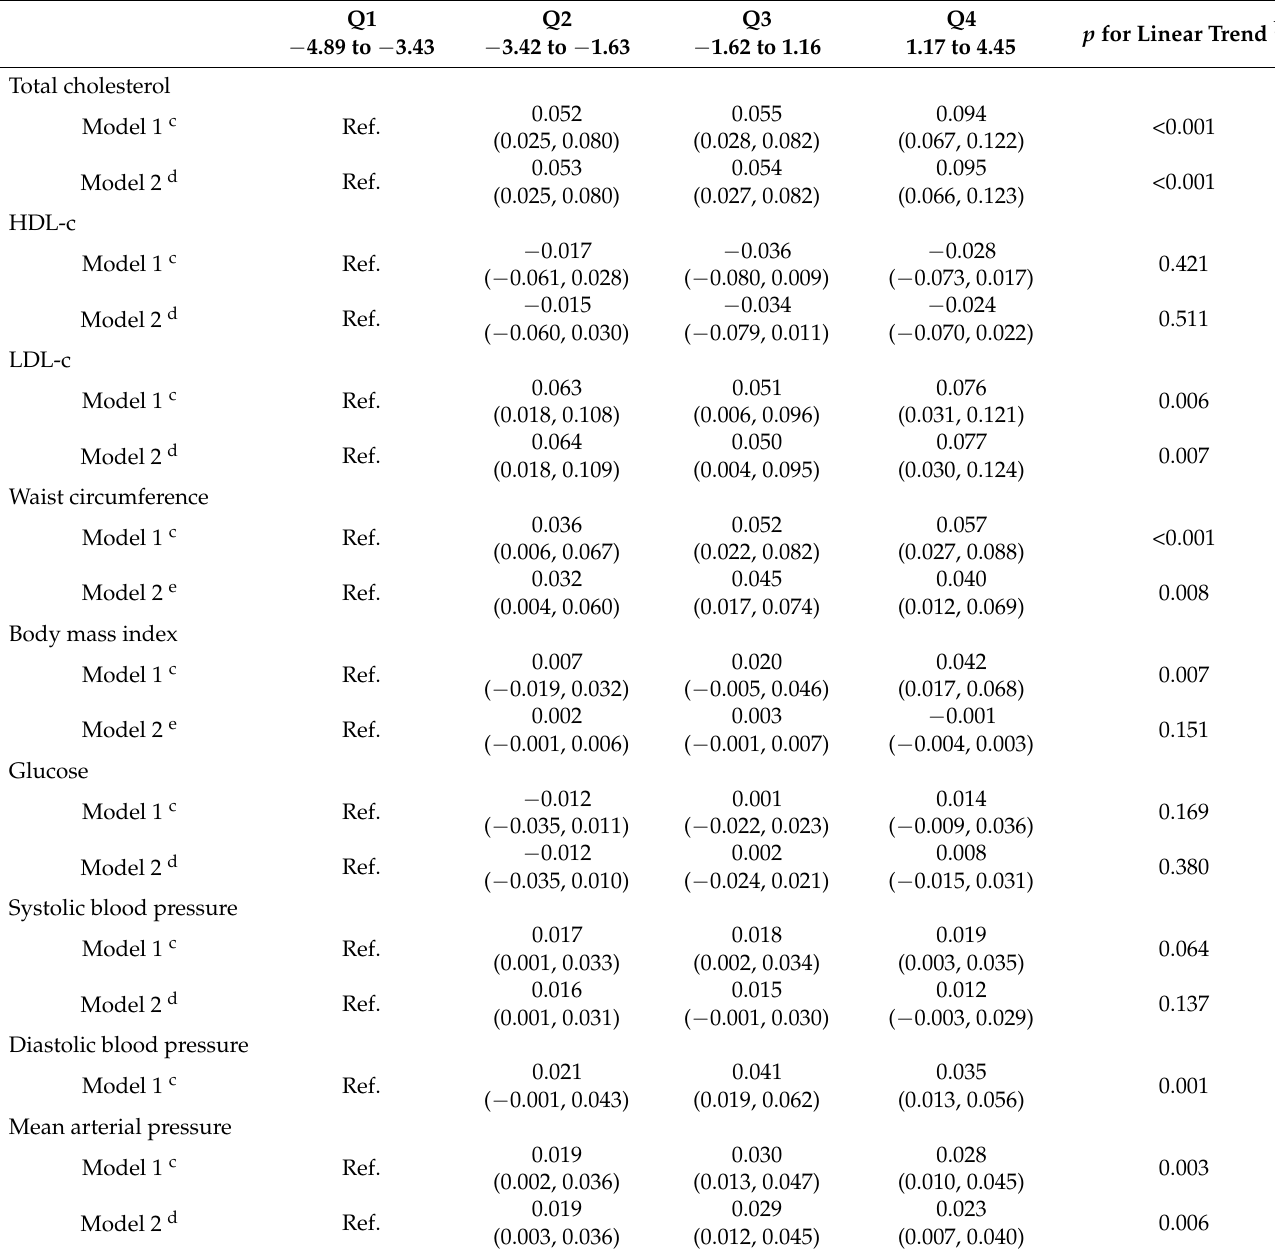
Q4 E-DII score quartiles were positively associated with total blood cholesterol, LDL-C, and triglyceride levels. It was also positively associated with pulse wave velocity, diastolic blood pressure, mean arterial pressure, BMI and waist circumference but not blood glucose, HDL-c, or systolic blood pressure. Table 4. The associations (beta regression coefficients (95% CIs)) between E-DII score quartiles and normalized car- diometabolic risk indicators among the 276 women participants a